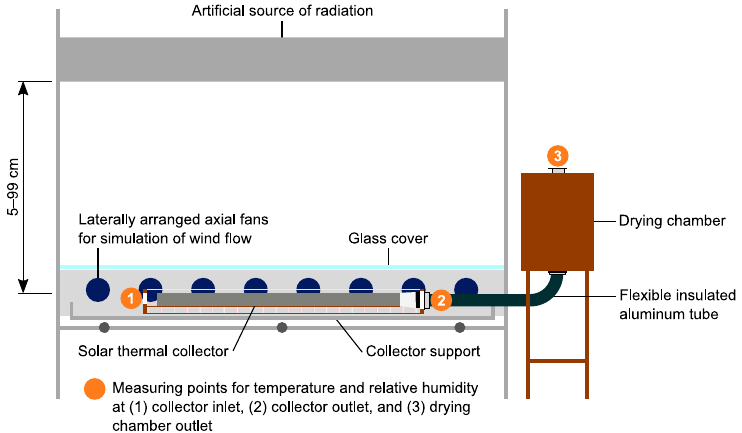
Figure 3. Indoor test facility with the solar collector, drying chamber, and relevant measuring points: ( 1 ) solar collector inlet, ( 2 ) solar collector outlet, and ( 3 ) drying chamber